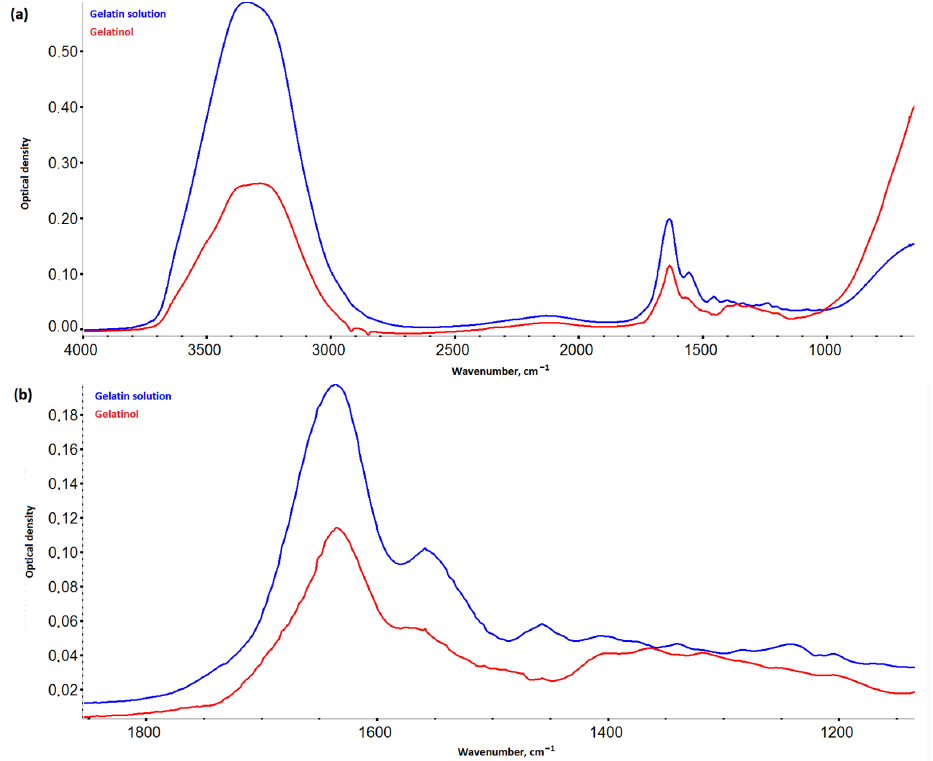
Figure 5. IR spectra of Gelatinol ® and 8% gelatin solution: ( a ) in the range 4000–800 cm − 1 ; ( b ) in the range 1900–1100 cm − 1 .